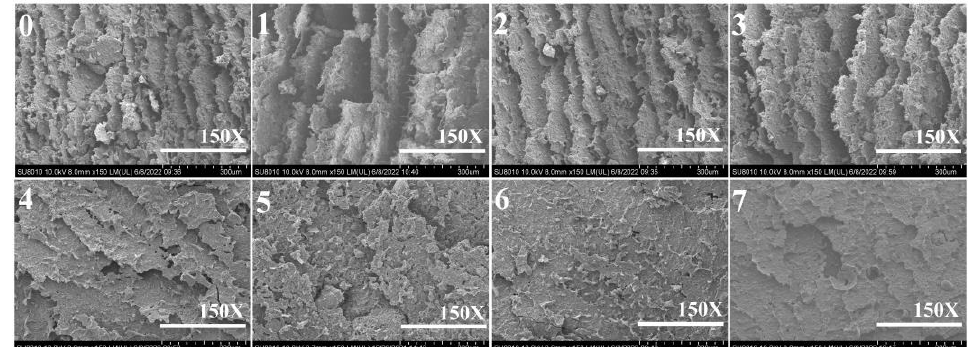
Figure 7. Fracture surface micrographs of the different cured adhesive samples: (0) HPM adhesive, (1) HPM-papain adhesive, (2) HPM-sodium dodecyl sulfate (SDS) adhesive, (3) HPM-urea adhesive, (4) HPM-PAE adhesive, (5) HPM-papain-PAE adhesive, (6) HPM-SDS-PAE adhesive, (7) HPM-urea-PAE adhesive.